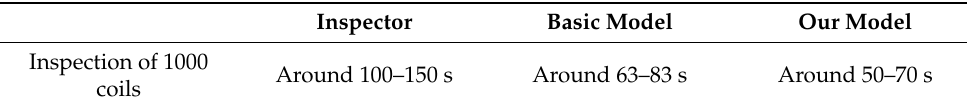
Table 10. Comparison of the number of inspections per